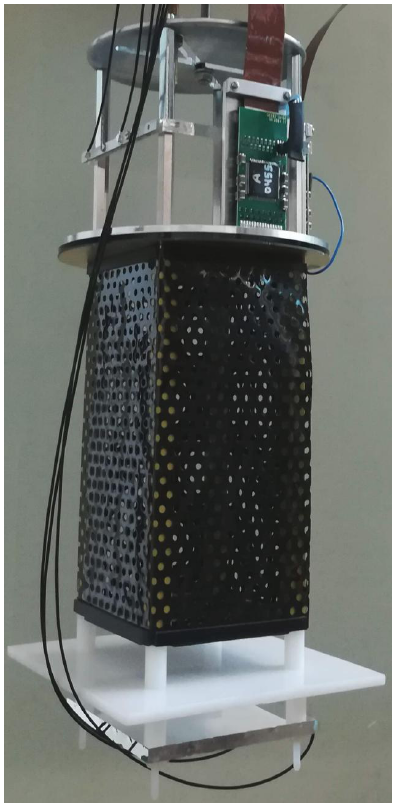
Figure 3. The Bern field-shell demonstrator LArTPC. The field-shell and cathode are made from ∼ 50µm resistive kapton foil. For this test, the field-shell was perforated to allow the purification of the LAr within the active volume. The Time Projection Chamber (TPC) has a 7cm × 7cm footprint and a 15cm drift length. A bias of up to − 23kV was applied to the cathode to generate a 1.5kVcm − 1 drift field